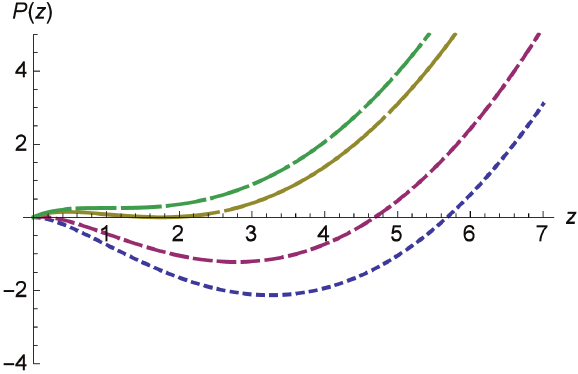
Figure 13. Pressure p ( z , θ ) as a function of normalized density z = ρ / ρ c , for the model of nuclear-drop-like object with equation of state with nuclear-fog interpolation [80]. Several values of normalized temperature θ = T / T c are shown: θ = 0 (lowest line), θ = 0.3 (second line from bottom), θ = 0.8255 (second line from top) which contains the point where p = ∂ z p = 0, and the critical isotherm θ = 1 (upper line) which contains the point where ∂ z p = ∂ zz p = 0. The lowest curve represents the hypothetical case where the thermal term in the expression for free energy is omitted. All curves below the critical isotherm, that is, when θ < 1, possess two turning points ( z 1 < z 2 ) where ( ∂ z p ) z = z that is, s 2 ( z i ) = 0. In the domain 0 < z < z 1 , the matter is in its gas state. In the domain z > z 2 , the matter is in its liquid state. Between z 1 and z 2 , lies the zone where the gas and liquid phases co-exist.